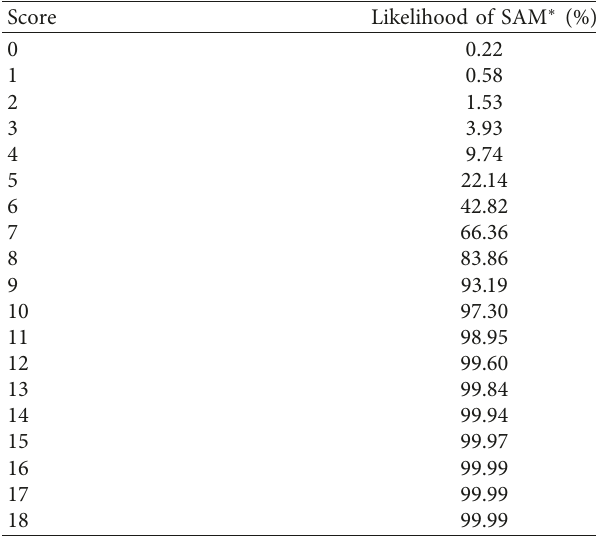
Table 3: Likelihood of SAM by score according to logistic re- gression